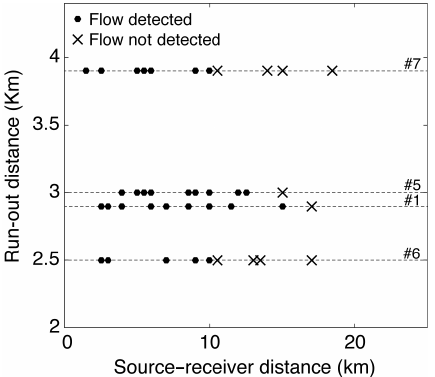
Figure 12. Run-out distances of the visually identified events ver- sus the source–receiver distances estimated for each seismic loca- tion.